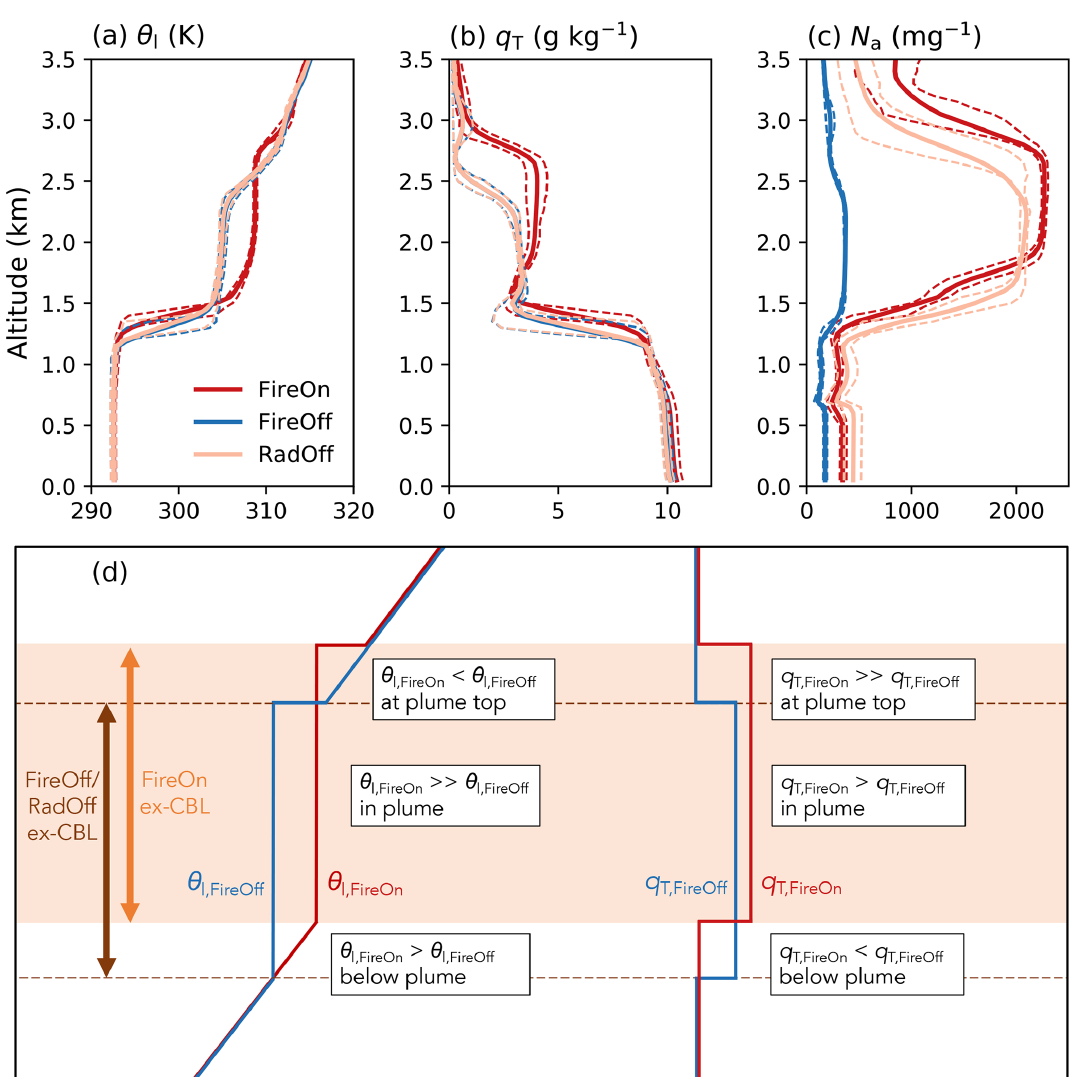
Figure 8. Snapshot of smoke contact and schematic of the idealized smoke displacement mechanism. Vertical profiles of (a) liquid water po- tential temperature, (b) total water mixing ratio, and (c) accumulation-mode aerosol number concentration for the WRF-CAM5 FireOn (red), FireOff (blue), and RadOff (pink) trajectories at 21:00UTC on 16 August 2017 (13.6 ◦ S, 4.8 ◦ W). Solid lines represent means and dashed lines the interquartile range. (d) Schematic of idealized thermodynamic profiles of “smoky” (FireOn; red) and “clean” (FireOff/RadOff; blue) ex-CBLs displaced vertically. “Plume top”, “in plume”, and “below plume” here refer to the location of the FireOn